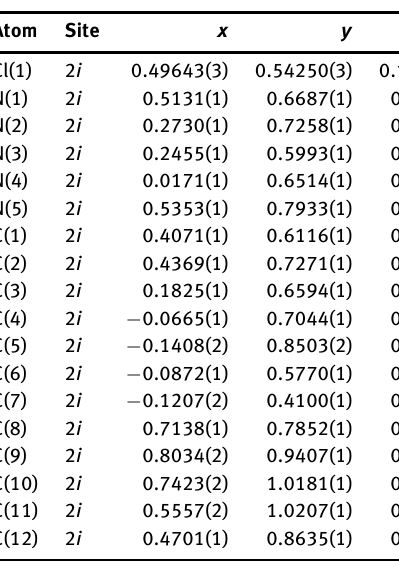
Table 3: Atomic displacement parameters (Å 2